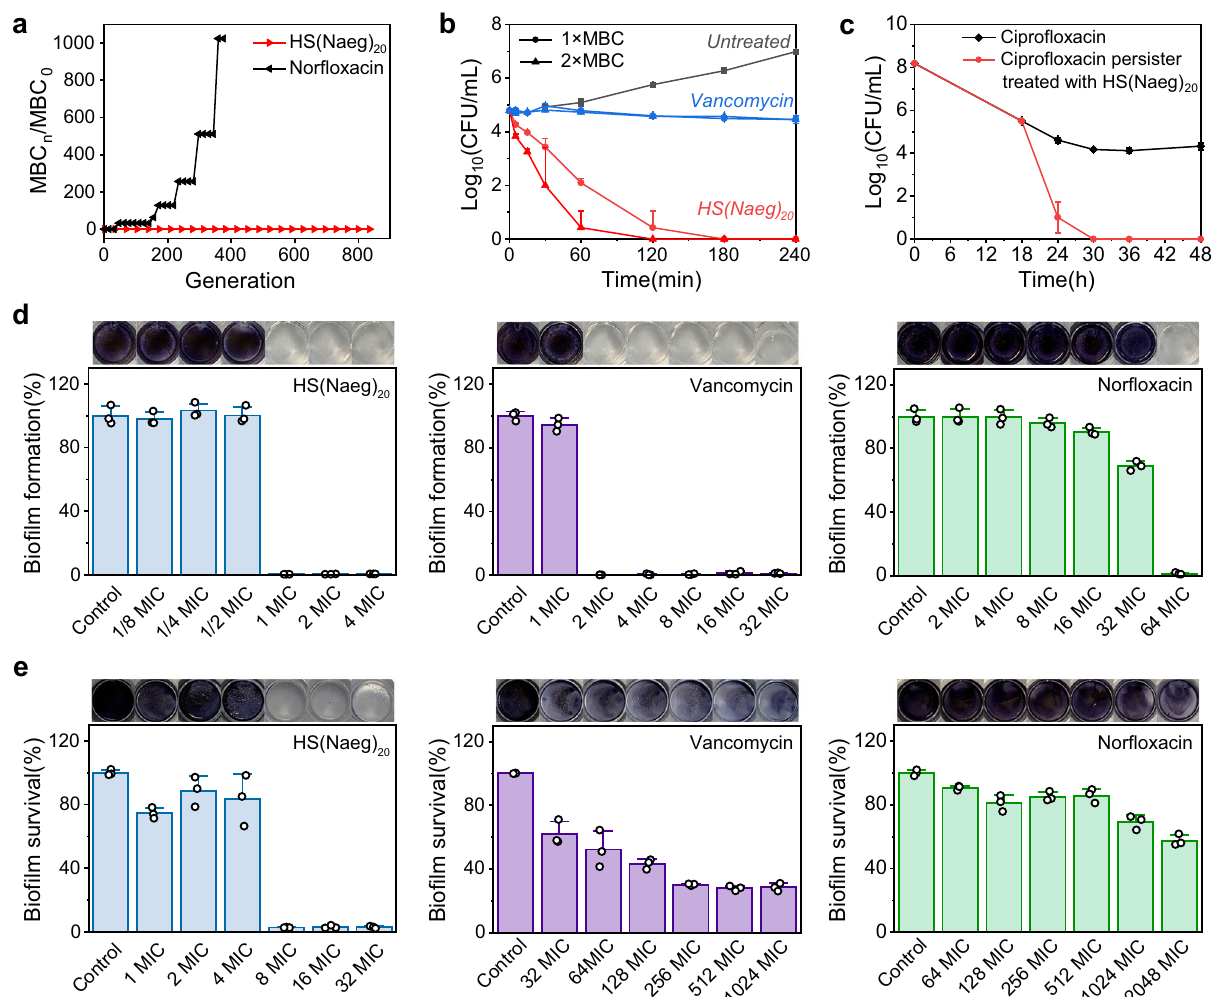
Fig. 4 Selected HS(Naeg) 20 displayed insusceptibility to antibacterial resistance, fast bacterial killing, ability to kill persister cells, and effective activity upon bio fi lms. a Antibacterial resistance test on HS(Naeg) 20 and nor fl oxacin against S. aureus ATCC6538. b Bacterial killing kinetics of HS(Naeg) 20 and vancomycin against S. aureus ATCC6538 at 1 × MBC and 2 × MBC concentration. c Killing kinetics of HS(Naeg) 20 against persister cells generated by high-concentration cipro fl oxacin treatment. d The inhibitory effect of HS(Naeg) 20 , nor fl oxacin, and vancomycin against MRSA bio fi lm formation. e The ability of HS(Naeg) 20 , nor fl oxacin and vancomycin to eradicate mature MRSA bio fi lm. n = 3 per group, data are presented as mean ±